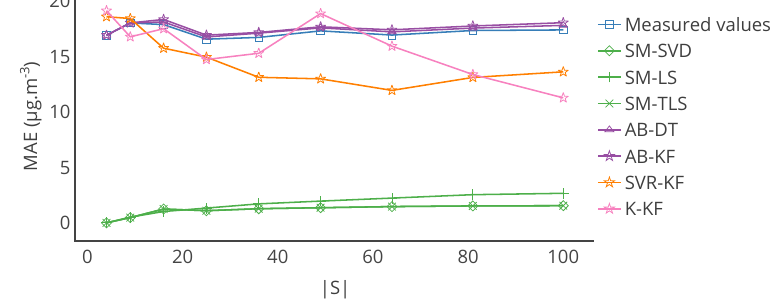
Figure 15. Evolution of the mean of the MAE, computed on the entire time interval of study, of all the nodes of the network, as a function of the number of nodes | S | , for the 2D Gauss